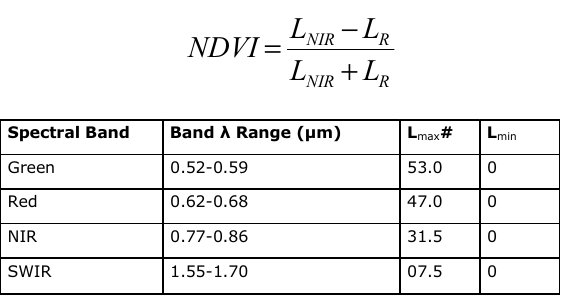
Fig. 2: Flow Chart of the methodology followed for data analysis.